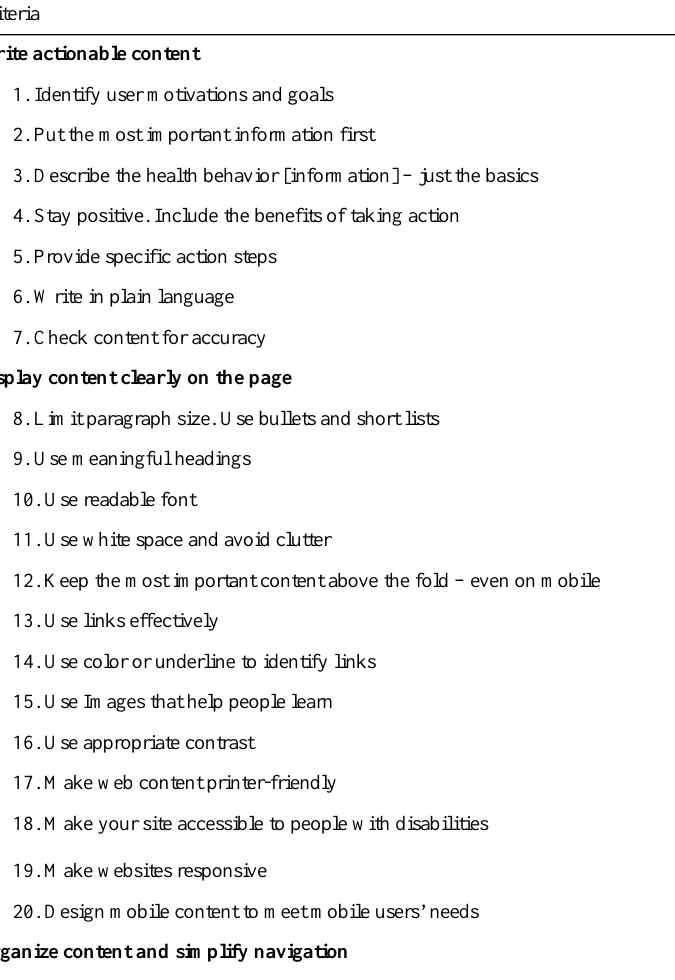
Table 2. Review of the Roadmap to Parenthood patient decision aid using the Health Literacy Online Strategies Checklist from the National Institutes of